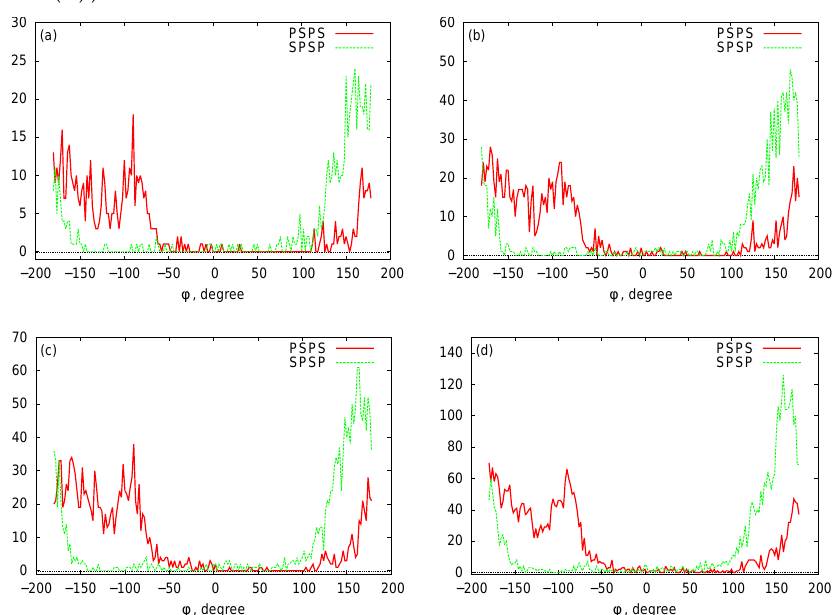
Figure 7. Histograms for the dihedral angles: ( a ) two-ring nanotube ( b ) four-ring nanotube ( c ) five-ring nanotube ( d ) 10-ring